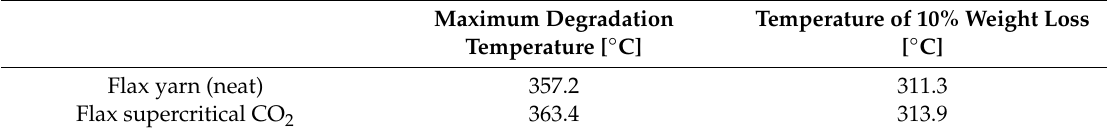
Table 2. Results of the thermogravimetric analysis for the untreated and scCO 2 treated flax yarns.